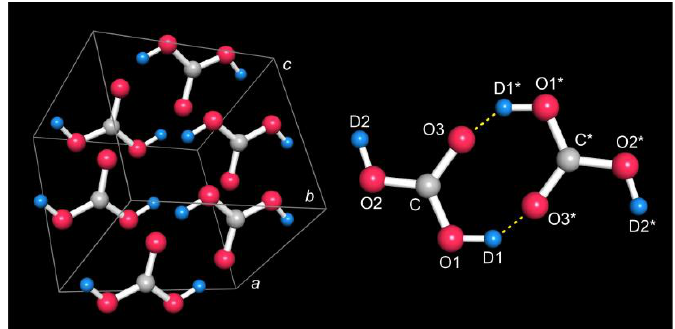
Figure 2. The crystal structure of carbonic acid. Shown is a perspective view [25] into the experimentally determined crystal structure ( left ) and the atomic numbering ( right ) of a dimer bonded through hydrogen-bridging bonds (dashed yellow lines); atoms generated by inversion have been indicated by asterisks, e.g., D1*.